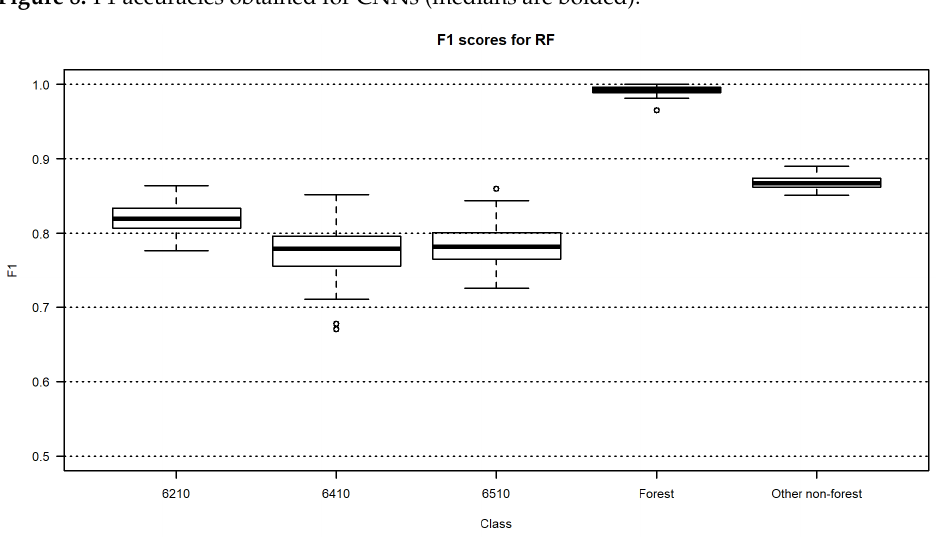
Figure 8. F1 accuracies obtained for CNNs (medians are bolded).